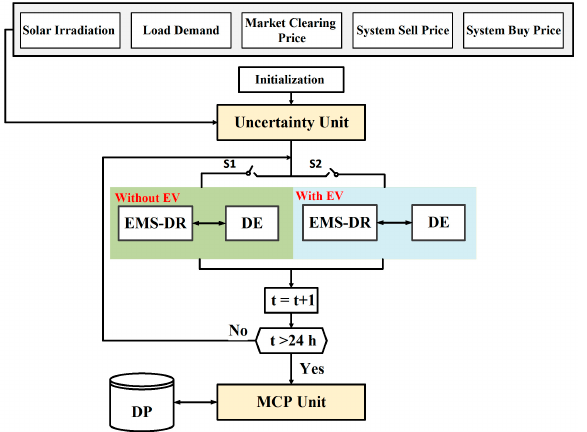
Figure 2. The structure of the proposed system .